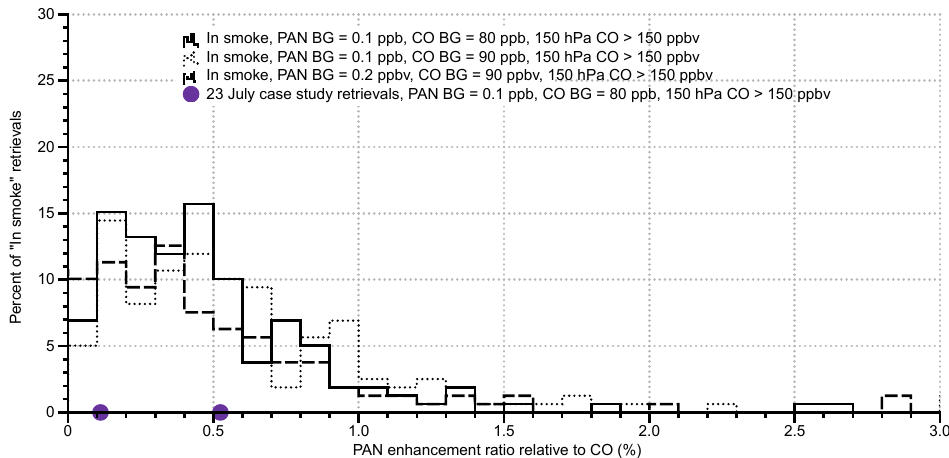
Figure 8. Histogram of estimated PAN enhancement ratios based on tropospheric mean PAN and CO from July 2006–2009 North American TES PAN retrievals overlapping HMS smoke plume polygons. The solid black line represents enhancement ratios calculated using an assumed PAN background of 0.1ppbv with an assumed CO background of 80ppbv. The dotted black line represents enhancement ratios calculated using an assumed PAN background of 0.1ppbv with an assumed CO background of 90ppbv. These specific enhancement ratios were calculated using an assumed CO background of 80ppbv, similar to the solid black line. The dashed line represents enhancement ratios calculated using a significantly higher assumed PAN background of 0.2ppbv with an assumed CO background of 90ppbv. In all cases, negative values are not shown. The purple dots are the enhancement ratios for the two circled retrievals on 23 July 2007 plotted in Fig. 7 associated with transported